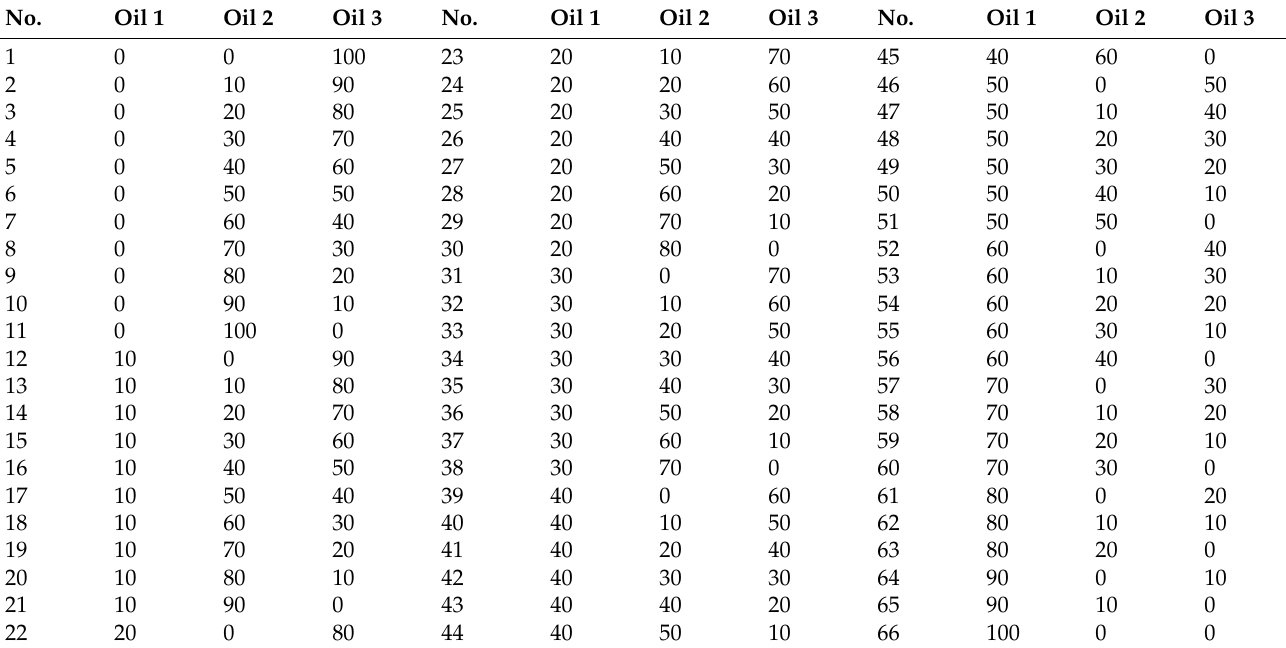
Table 2. The percentages of each oil in ternary oil